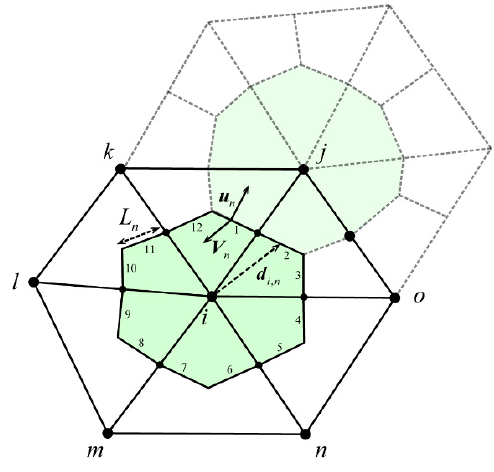
Figure 4. Control volume of UFVM.